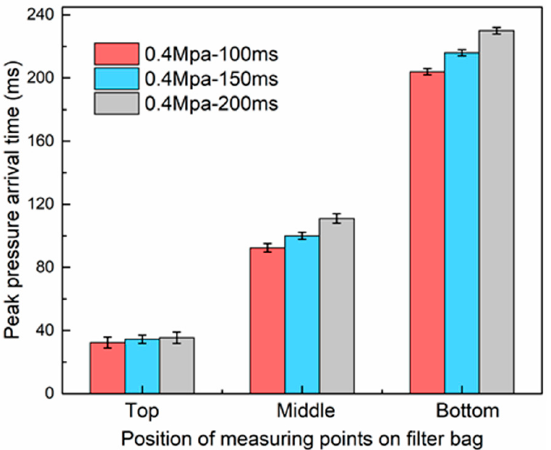
Figure 8. Effect of the pulsing air injection time on the peak pressure arrival time of filter bag.